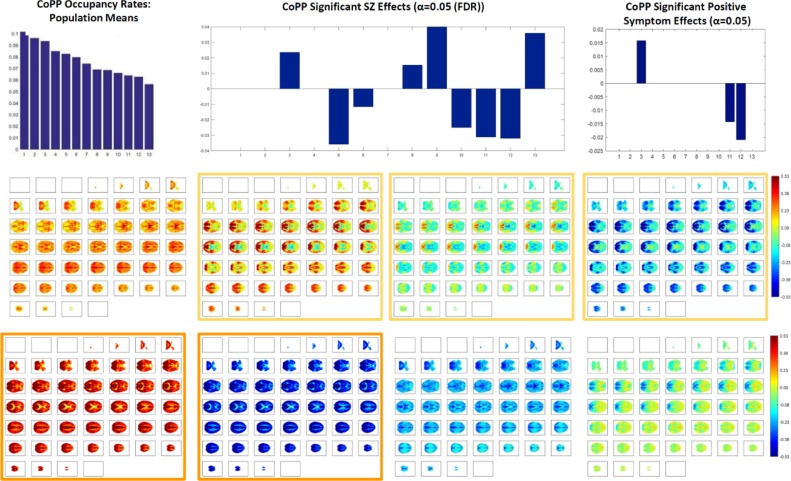
Polarity coded 3D volumes distribute into 13 clusters, all of which exceed 6% occupancy at the population level (top left); among these clusters are two whose centroids are pervasively strongly polarized (bottom row, first and second column); SZ has a significant negative (p<0.05 (FDR)) effect on occupancy of the two most strongly polarized CoPPs (bars at x = 11 and x = 12 in top-center bar plot); within the patient population there is also a significant negative effect of positive symptomology, including the key psychotic symptoms (delusions and hallucinations) on occupancy of the most strongly and pervasively polarized states (right-most bars in top right bar plot). The positive symptom effect within the patient population is significant at the raw α = 0.05 level without surviving the stronger multiple comparison threshold.